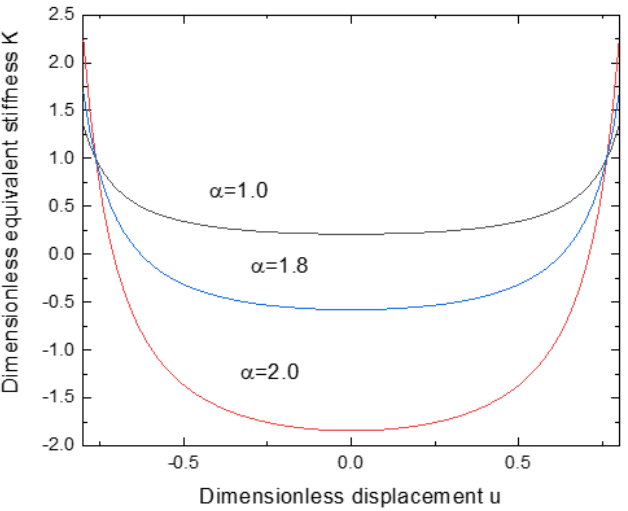
Figure 5. Dynamic stiffnesscurves with linear stiffness for the various values of α